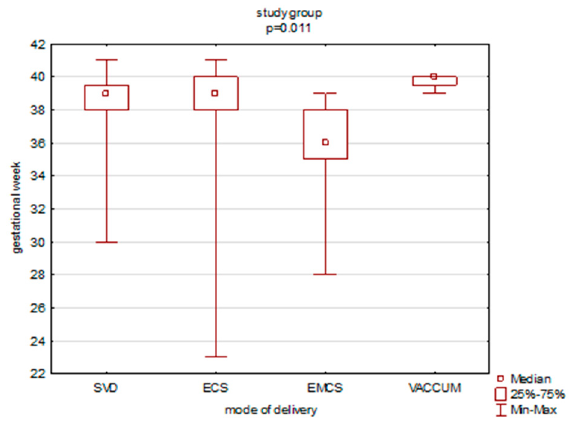
Figure 2. Mode of delivery versus gestational week in the study group. SVD—spontaneous vaginal delivery; ECS—elective cesarean section; EMCS—emergency cesarean section; VACCUM—vacuum extraction.